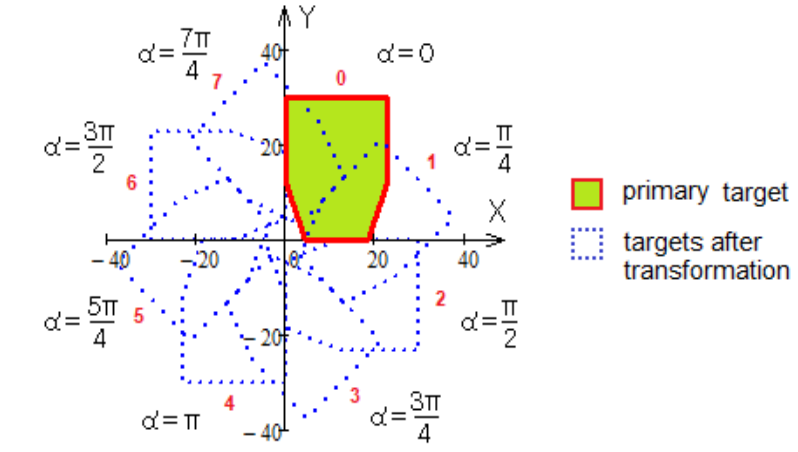
Figure 7 – Target rotating process using eight different angles Рис . 7 – Процесс вращения мишени с использованием восьми углов поворота Слика 7 – Поступак ротације мете коришћењем осам различитих